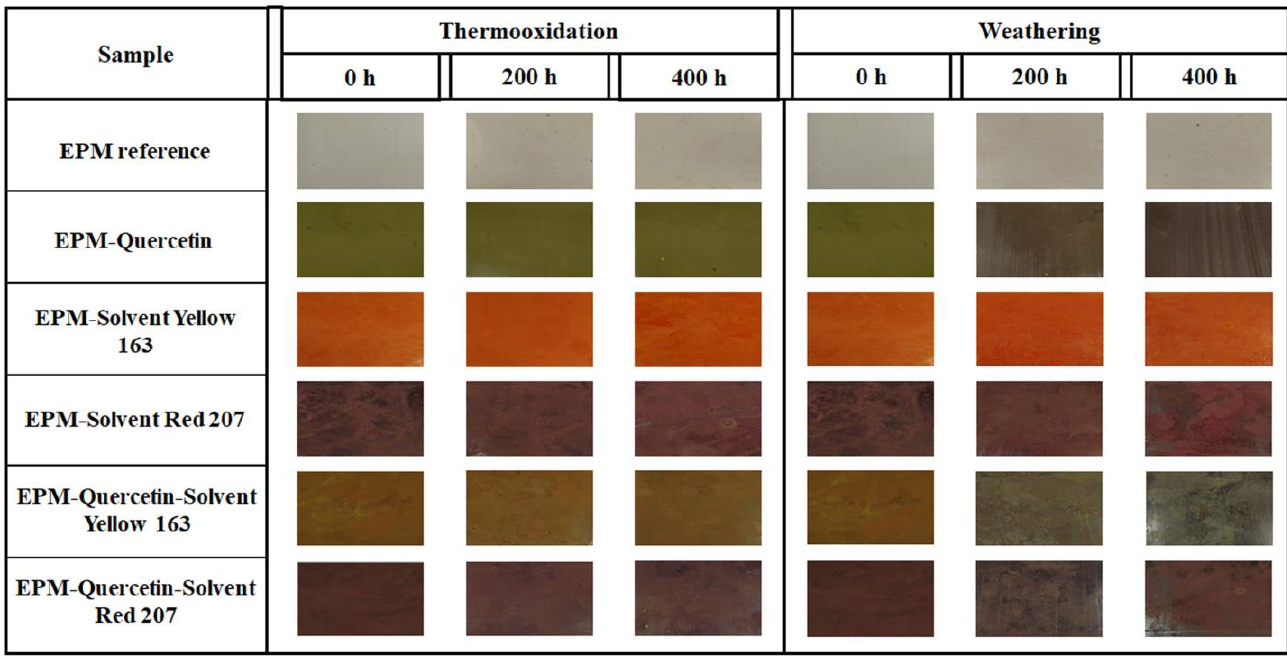
Figure 7. Visualization of ethylene-propylene based materials before and after 200 and 400 h of thermo-oxidation and weathering.